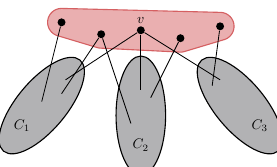
Figure 4. The glue operation: We have already guessed the vertex v and currently consider the ( C 1 , ρ 1 ) , ( C 2 , ρ 2 ) , ( C 3 , ρ 3 ) set X = . Note that all blocks are adjacent to v and are pairwise non- N ( C ) and the set X = fl . ( C 1 ,fl 1 ) , ( C 2 ,fl 2 ) with fl i œ { } Æ { } C 1 = . The intersecting. The combined neighborhood is highlighted. This area is not allowed to be larger than fl ÿ fl , as the ≠ ρ 1 , ρ 2 , ρ 3 max , as the searchers must clean it before they can proceed the search on one of the k − { } C 1 C 2 v ,fl +1), if the neighborhood of this set is at most k fl 1. fi fi fi{ } ≠ ≠ ) ρ 1 , ρ 2 , ρ 3 blocks. From this situation, we generate the block ( C 1 ,1 + max C 2 C 3 v ∪ ∪ ∪ { } { }